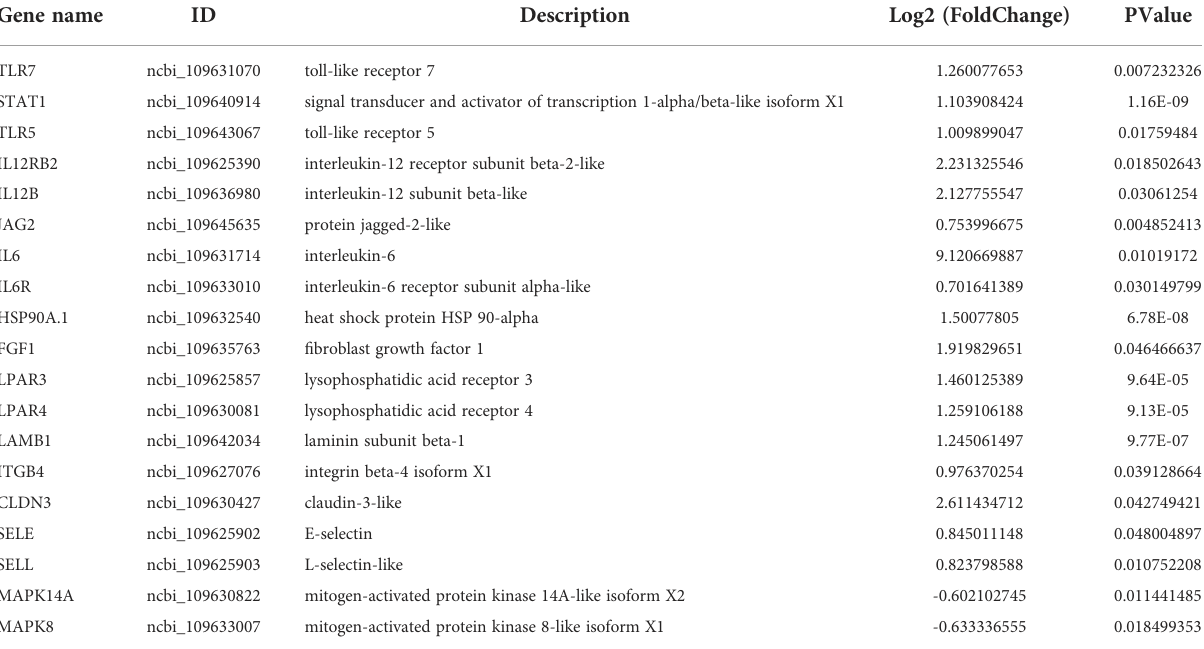
TABLE 7 Summary of immune-related genes in the inactivated vaccine group compared to the PBS group at 7 th post challenge